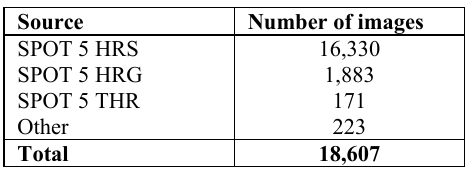
Table 1: Number of images in the global block HRS tiles can cover a large area, because of the swath of 120km of the sensor. The length of an image (along track) is usually 300km up to 600km. As a consequence, tiles are often heavy files composed up to 12,000 x 120,000 pixels. HRS images are acquired in stereoscopy with a B/H of 0.8. HRG images have a swath of 60km with a pixel of 10m in XS mode or 5m for panchromatic